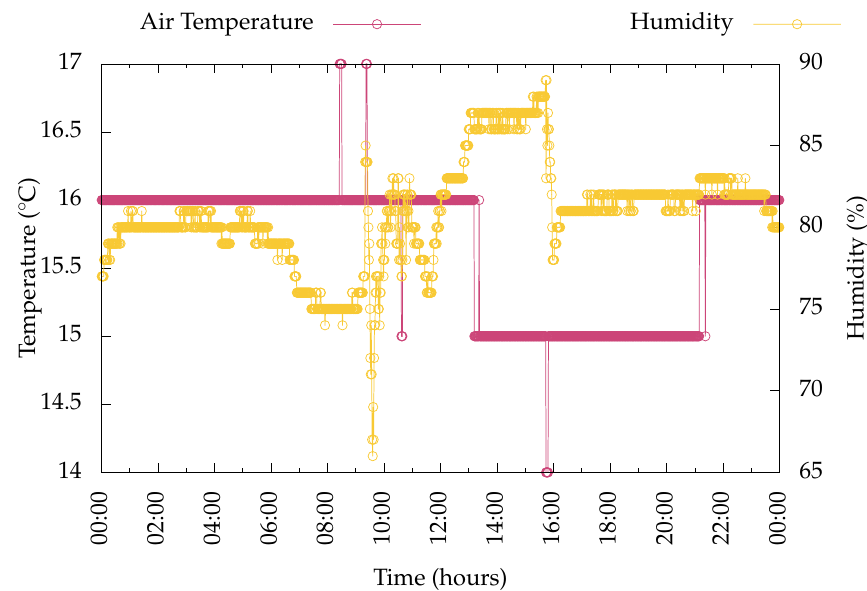
Figure 13. Air temperature and humidity data from DHT11 sensor at node 5FTH.